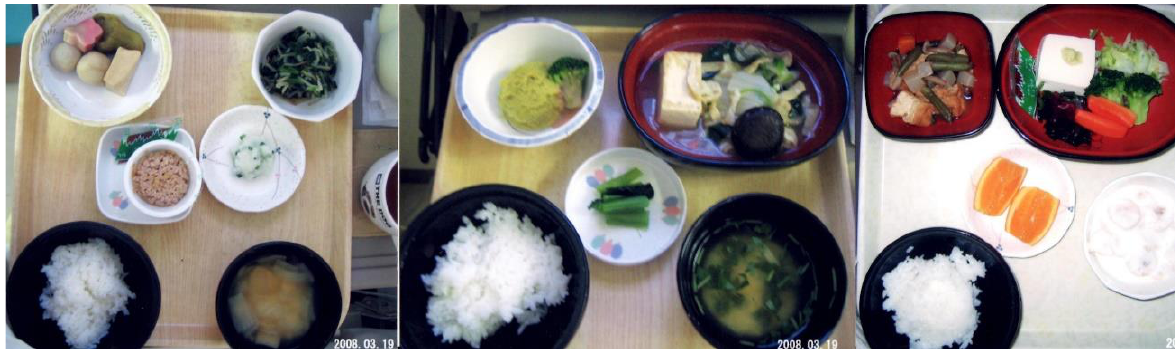
Figure 9. Semi-vegetarian diet (1400 kcal/day). From left to right: breakfast, lunch, and supper.